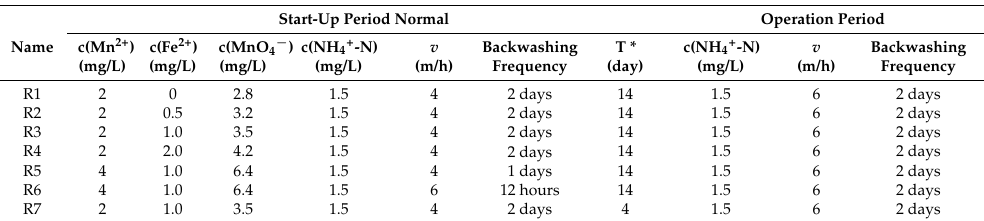
Table 2. The operating parameters of all the filters during operation period (start-up period and normal operation